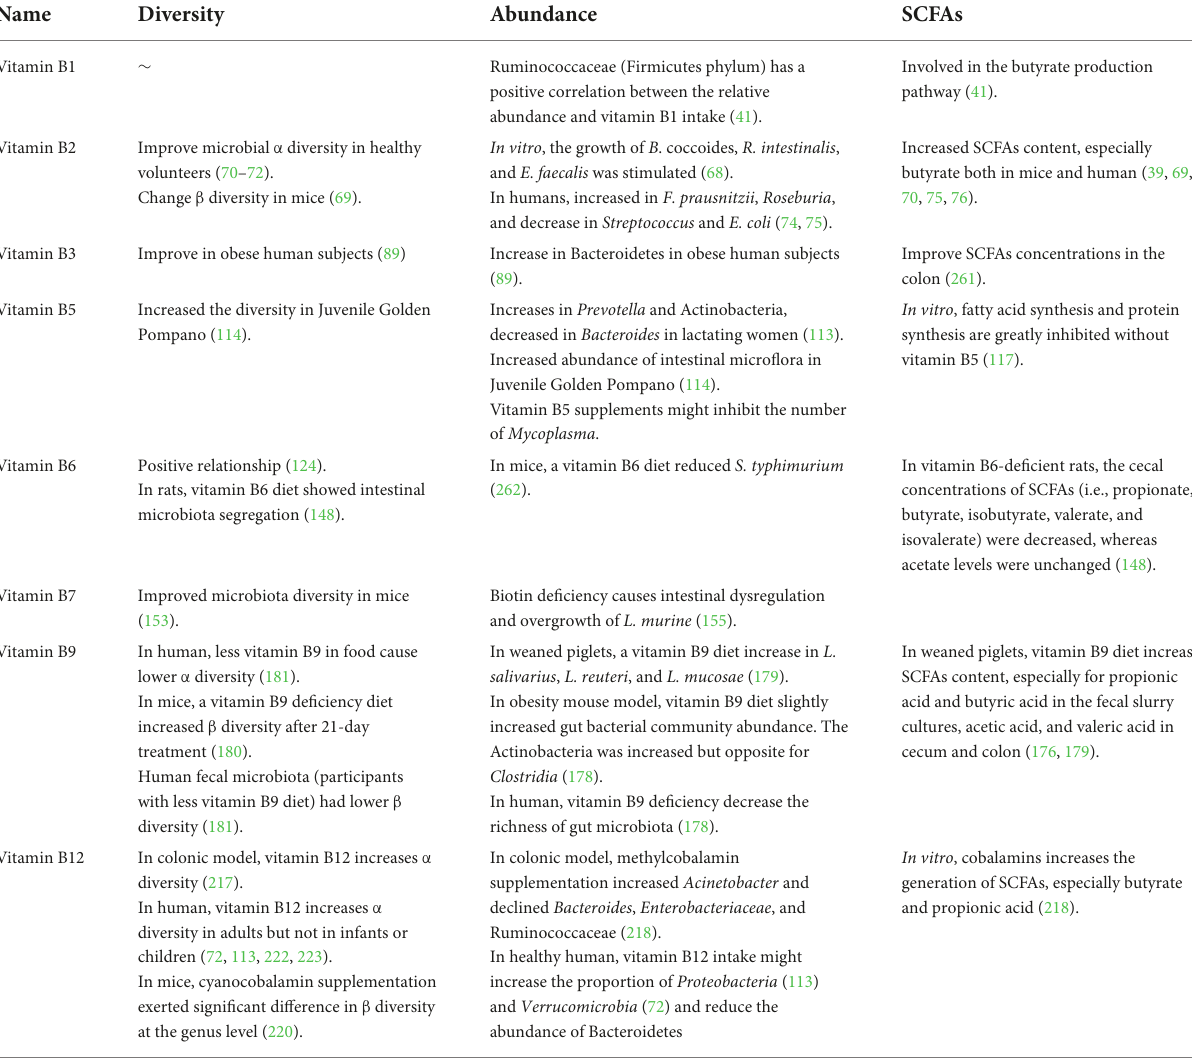
TABLE 4 Influence of vitamin B on gut microbial